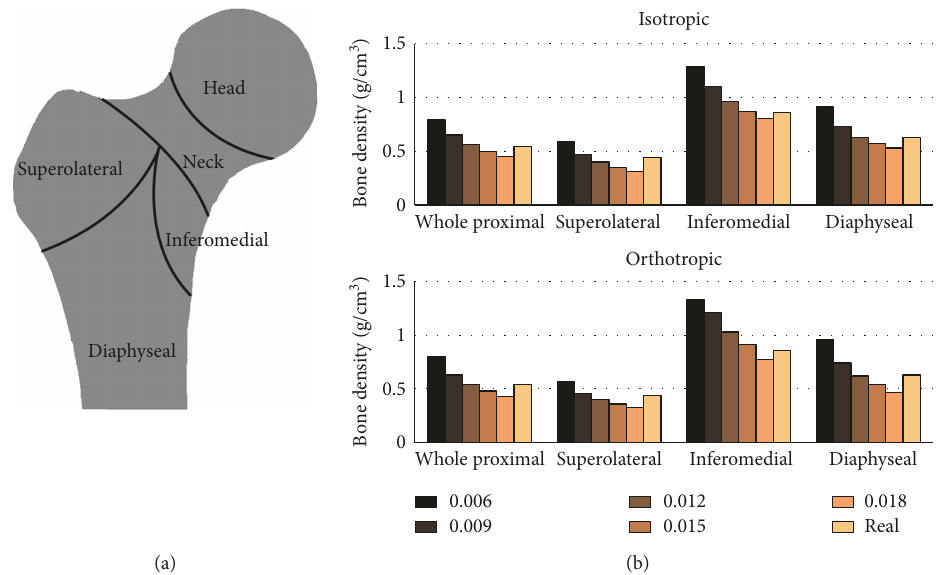
Figure 1: (a) The local regions in the proximal femur, including the superolateral, inferomedial, diaphyseal, and femur head and neck. (b) The real and simulated bone densities (g/cm 3 ) in the local regions of the proximal femur. The real densities are obtained from CT data. The simulated densities are calculated by the isotropic and orthotropic material algorithms, respectively.